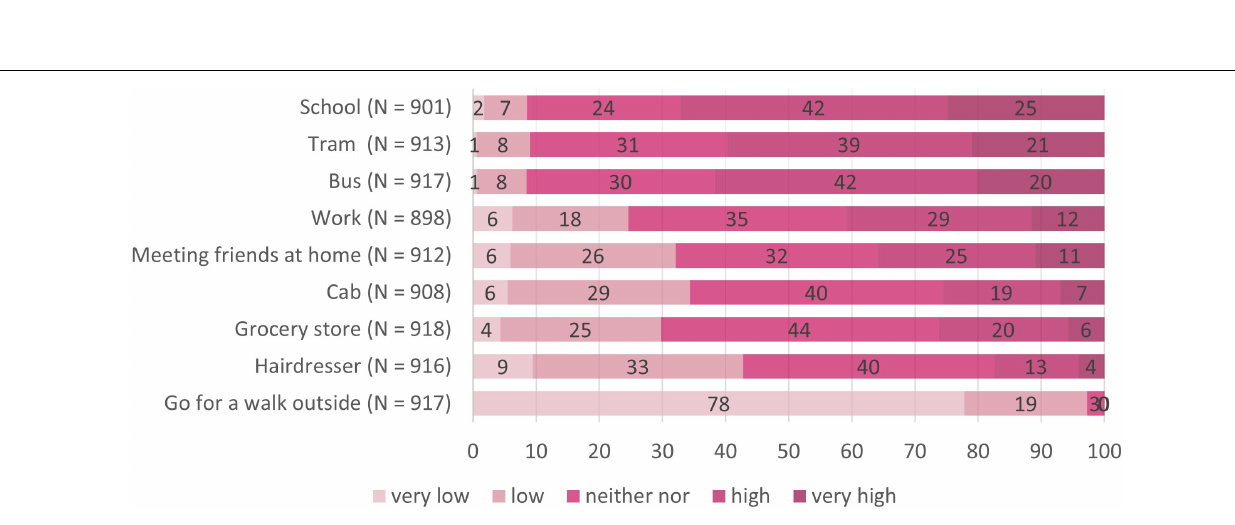
Frontiers in Psychology |